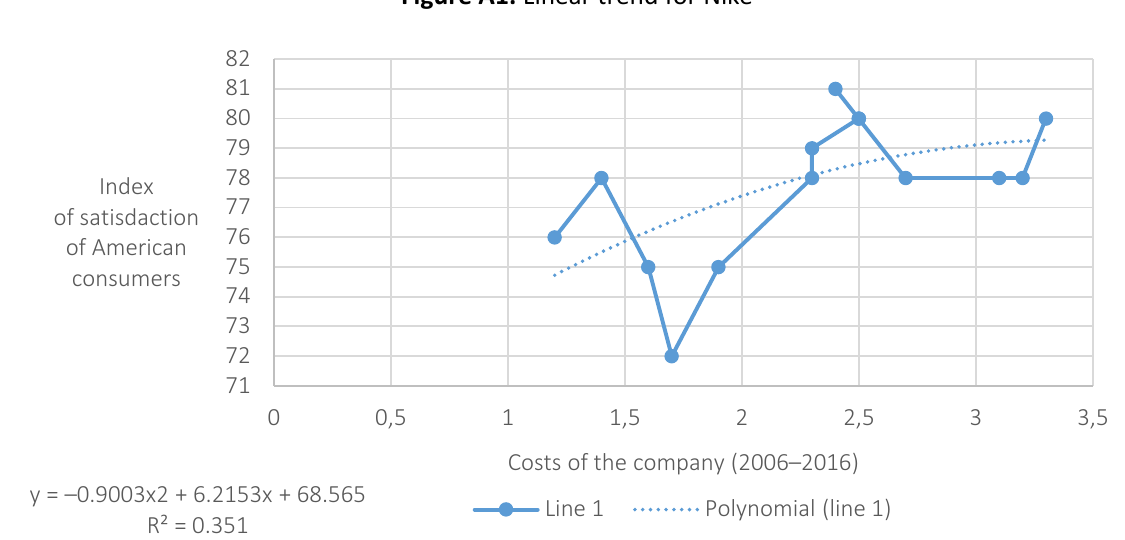
Figure A1. Linear trend for Nike